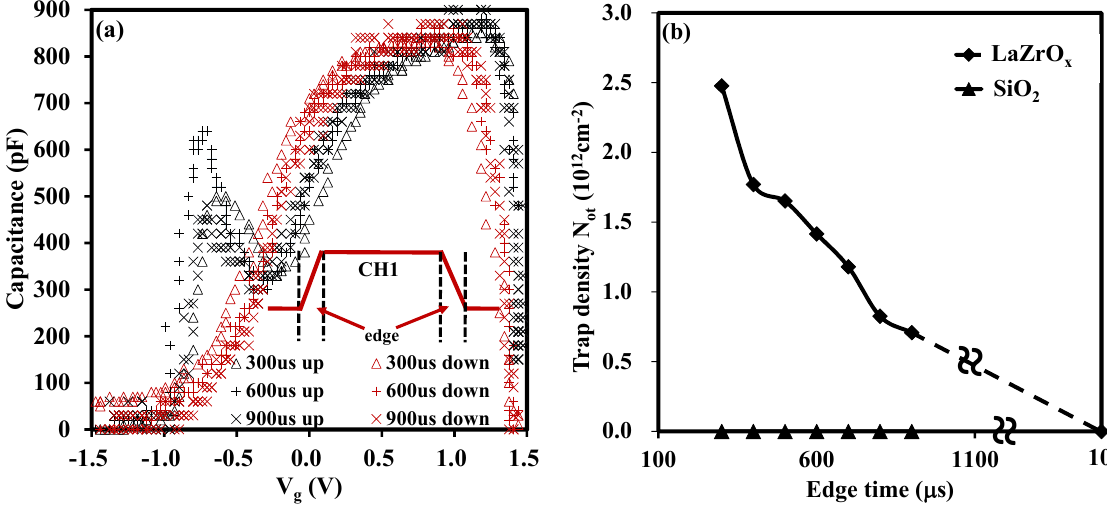
Figure 3. ( a ) Capacitance versus gate voltage with various edge time for LaZrO x (thickness of the stack about 22 nm); ( b ) Variation of N ot versus edge time for LaZrO x and SiO 2 . The large edge time means long test time in the measurement and the N ot observed will decrease with the increase of test